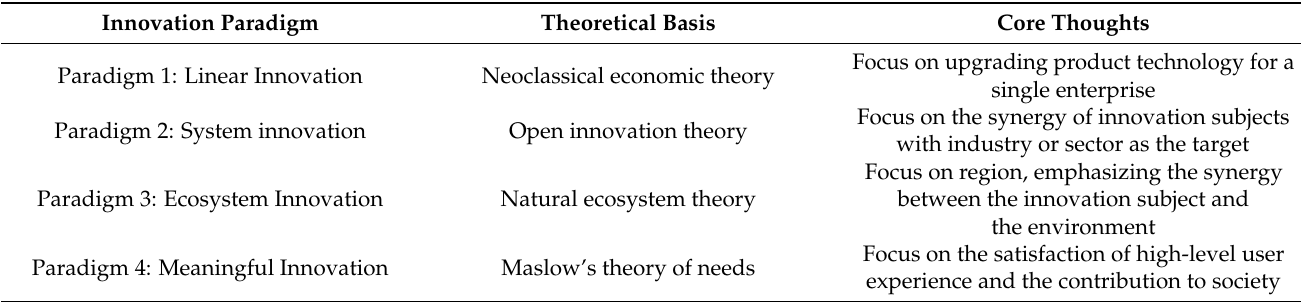
Table 1. Evolution of innovation paradigm.